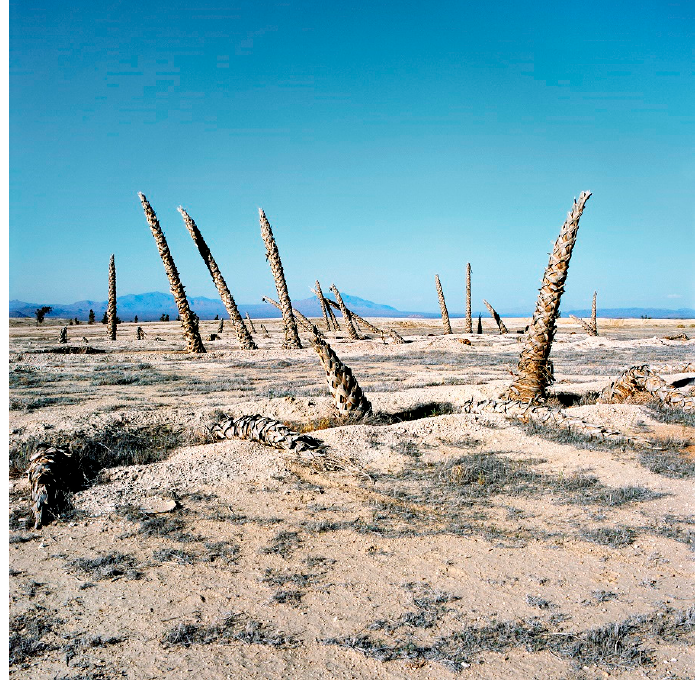
Figure 29. Anthony Hernandez, Discarded #42 (2012), © Anthony Hernandez.